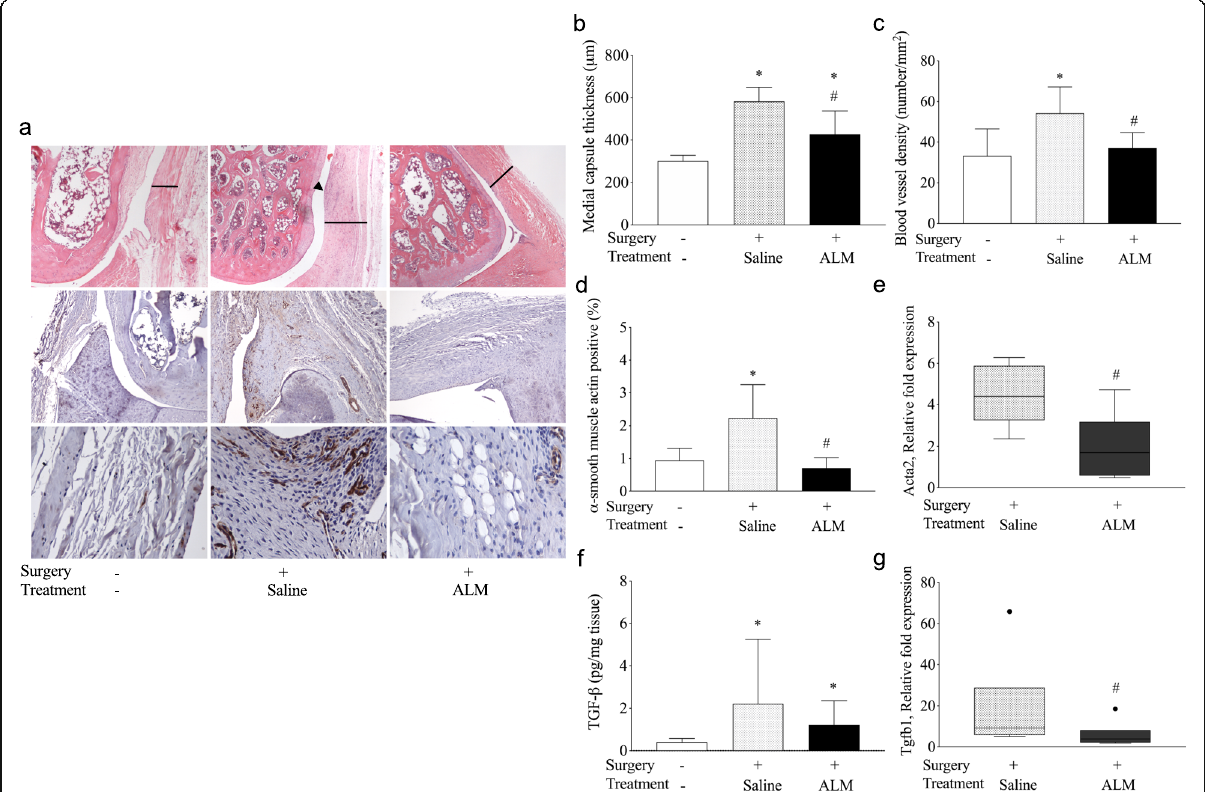
Fig. 3 ALM reduces fibrosis in joint capsular tissue following knee implant surgery. Four weeks after knee implant surgery, animals were sacrificed and anteromedial capsular tissue dissected from operated and non-operated knees. Remaining intact knee joints were decalcified and processed for histology. a Representative stained section of the medial joint capsule (upper panels: hematoxylin and eosin; magnification, × 40; middle and lower panels: α -SMA, magnification, × 100 and × 400) from non-operated, operated saline-treated and ALM-treated knees. b Thickness of the medial joint capsule (black bar) was measured. At 4 weeks post-surgery, medial capsule thickness was significantly reduced in operated knees of ALM-treated animals, compared to saline controls. c Compared to saline controls, blood vessel density was significantly lower in medial joint capsular tissue from ALM-treated animals. d α -SMA staining was also significantly reduced in ALM-treated animals compared to controls. e Similarly, mRNA expression of α -SMA ( Acta2 ) was significantly reduced in joint capsular tissue from ALM-treated animals, compared to controls. f Protein and g gene expression of TGF- β 1 was also lower in the joint capsule of knees from ALM-treated animals. Data are expressed as mean ± SD. Data shows mean ± SD, * P < 0.05, vs. baseline (no surgery, no treatment), # P < 0.05, compared to saline controls; n = 6 per